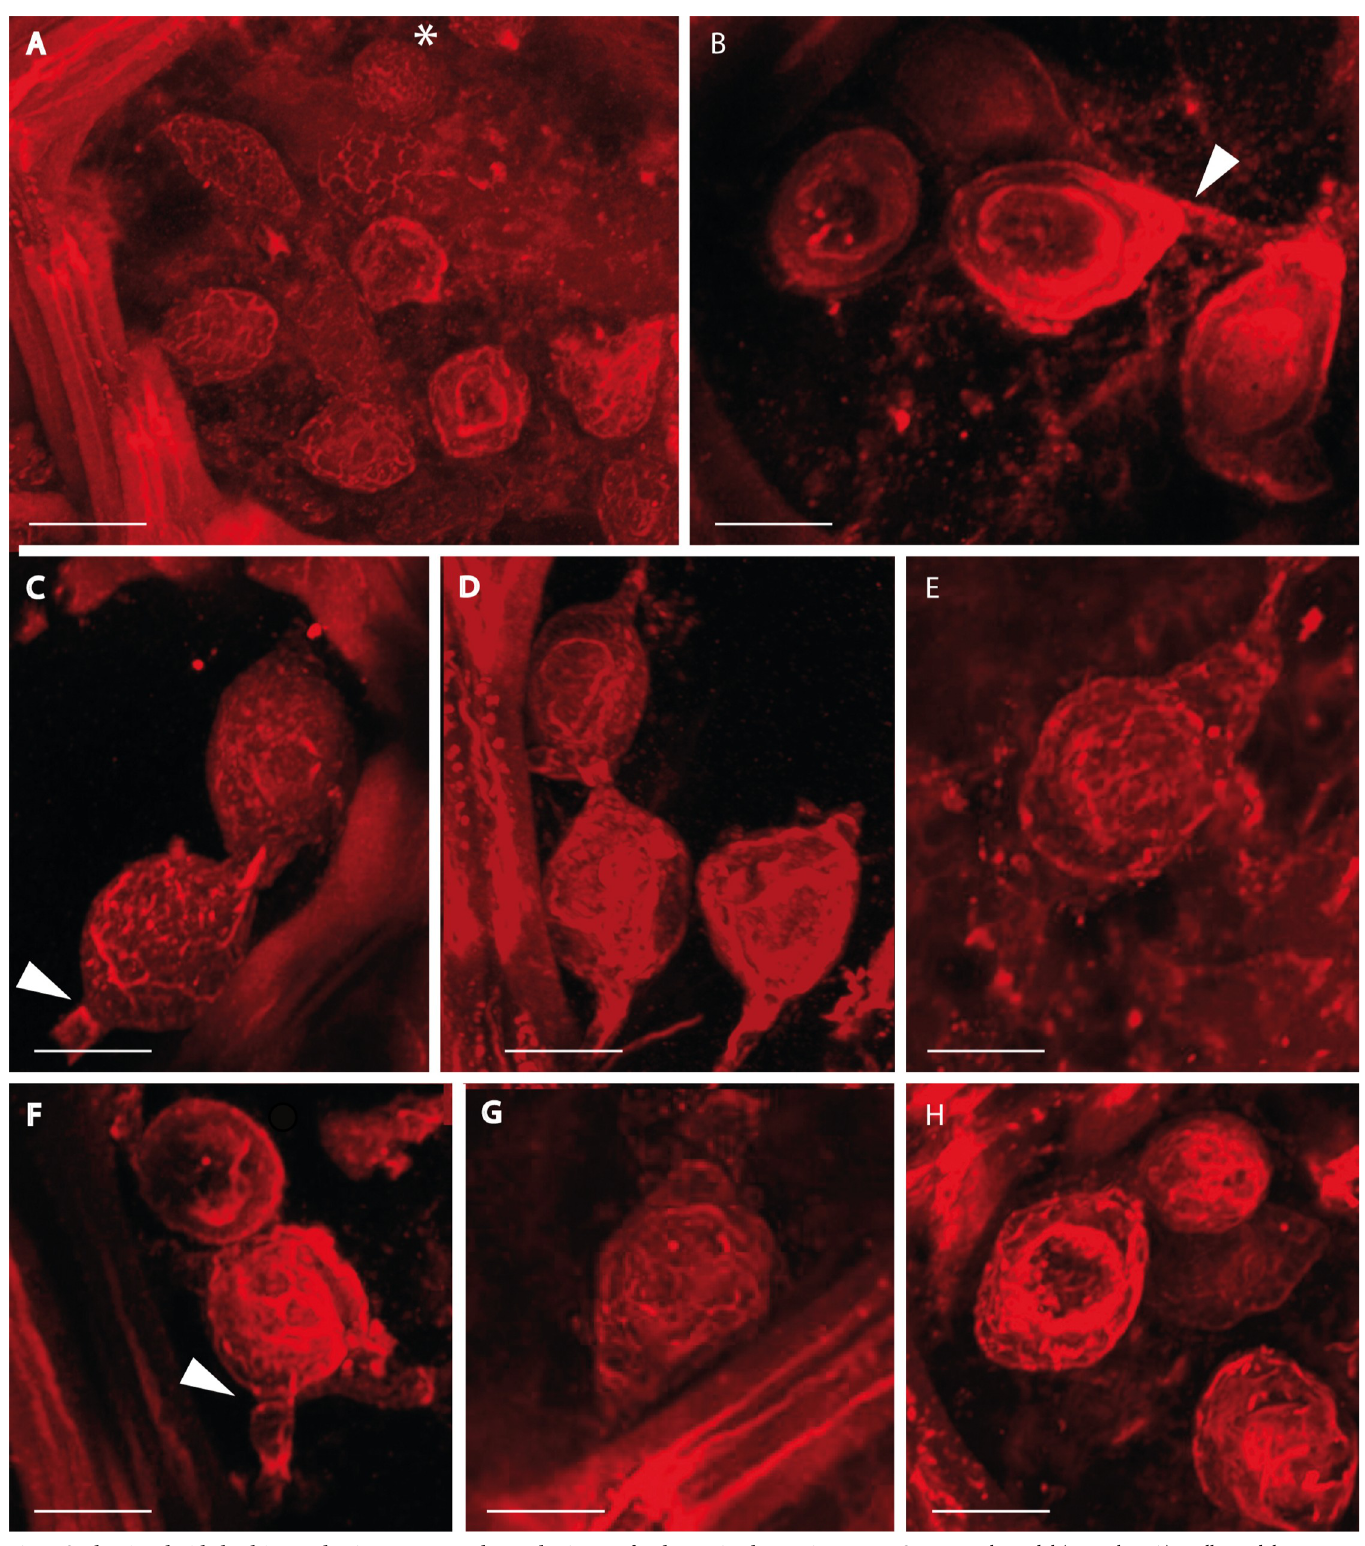
Fig 3. Oochytrium lepidodendri reproductive structures observed using confocal scanning laser microscopy. Oogonia spheroidal (asterisk in A) to ellipsoidal discharged within the xylem cells. Oogonia detached because of broken hyphae (B, E, G) or arranged in short linear arrays (catenulate) (C, D, F, H). Hyphae developing